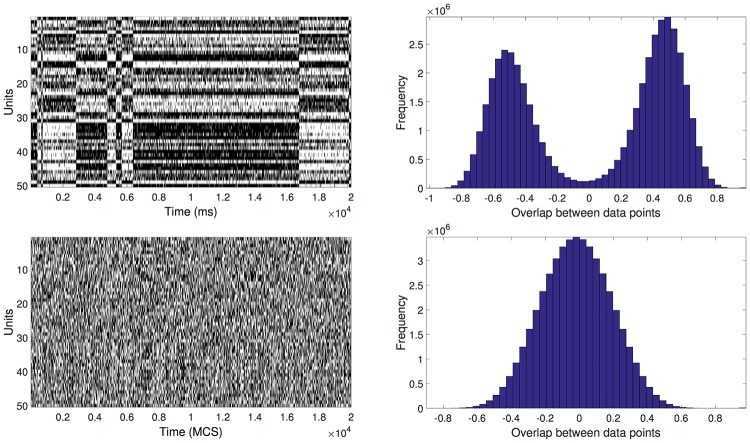
Hopfield network dynamics for two temperatures.Left column: The horizontal axis represents the time in MCS, while the vertical axis identifies the different units. White (black) pixel in the matrix entry (i, j) means that the i unit had a value -1 (1) at MCS j. Right column: Histogram of the overlaps between the MC configurations. Top panels correspond to a case of low temperature (β = 1.3), and bottom panels to one of high temperature (β = 0.83).